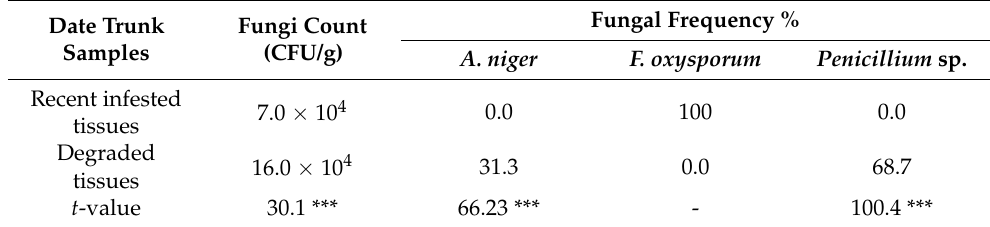
Table 2. Fungal count (CFU) and frequency % on date palm infected with RPW.